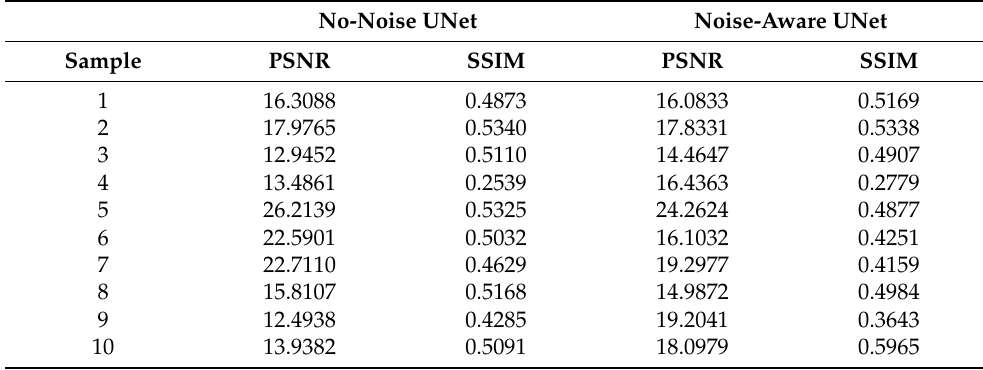
Figure 9. Raspberry Pi setup for model execution and inversion. Table 1. Test performance achieved on the raspberry pi by UNet model on Salt data.